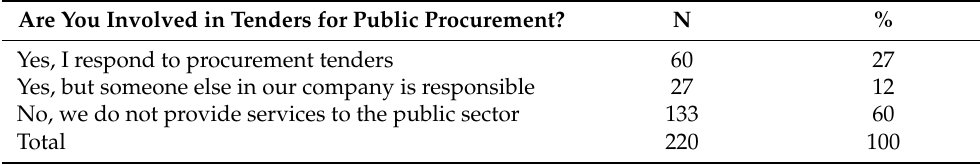
Table 4. Respondent’s role in freight